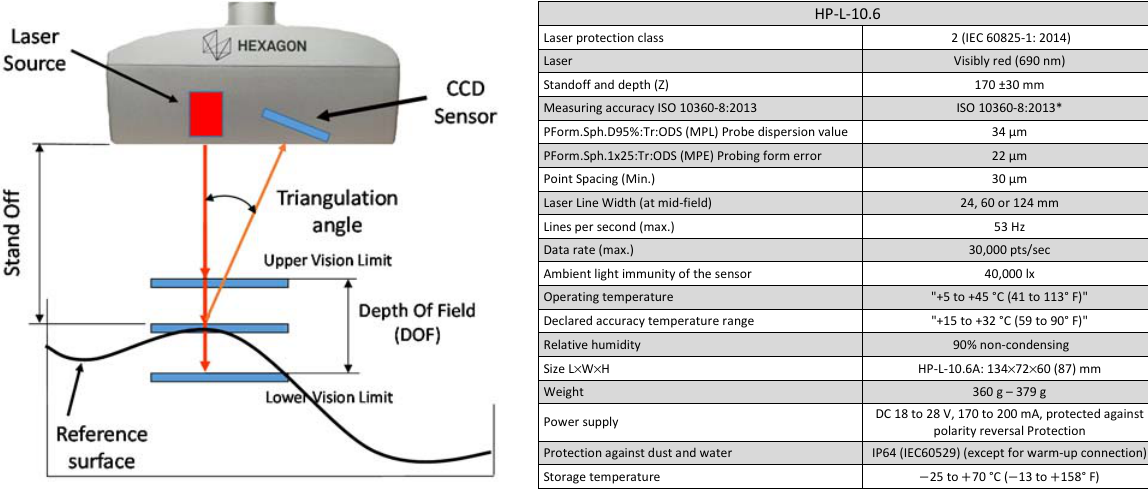
Figure 1. Principle of laser triangulation scanning.